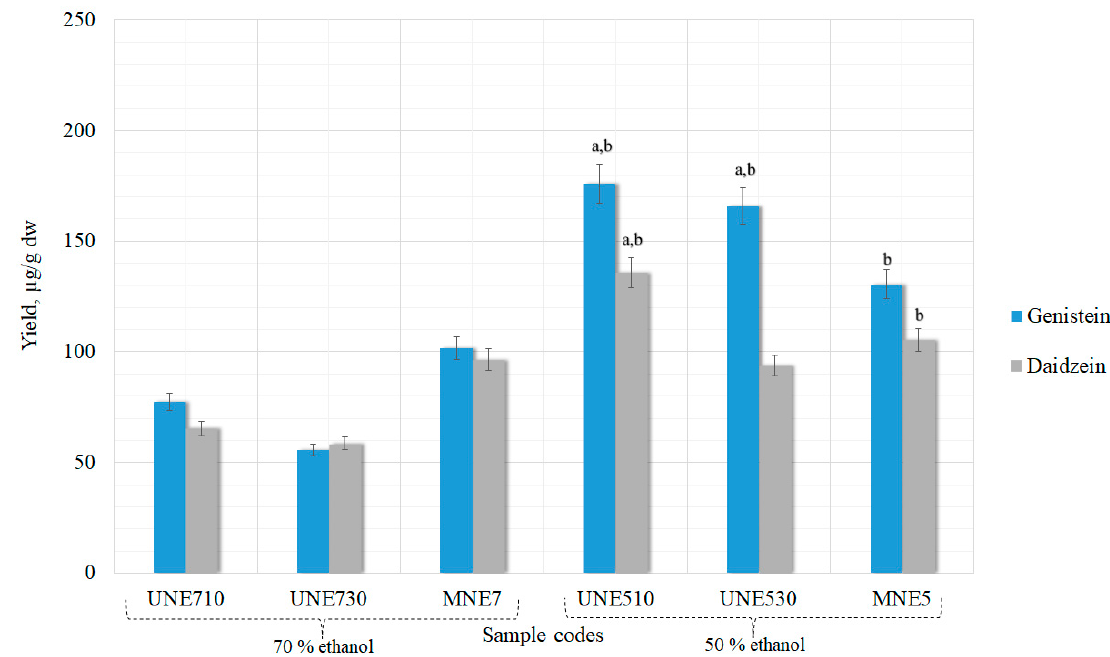
Figure 4. Influence of UAE treatment time and solvent concentration without hydrolysis on the maximal extraction yield of genistein and daidzein in extracts. a p < 0.05 vs maceration with 50% ethanol (MNE5); b p < 0.05 vs maceration with 70% ethanol (MNE7). Sample codes and preparation conditions are displayed in Table 1.